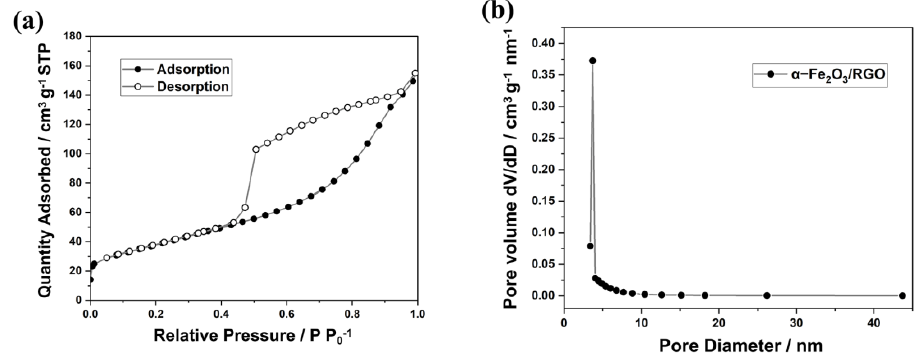
Figure 4. ( a ) N 2 adsorption and desorption isotherms for the α -Fe 2 O 3 /RGO samples; ( b ) pore size distribution of α -Fe 2 O 3 /RGO.